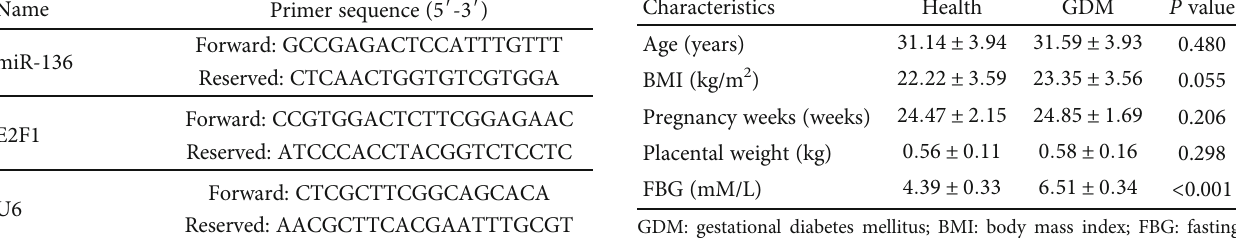
Table 1: Primer sequences for qRT-PCR. Table 2: Baseline characteristics of the study population.